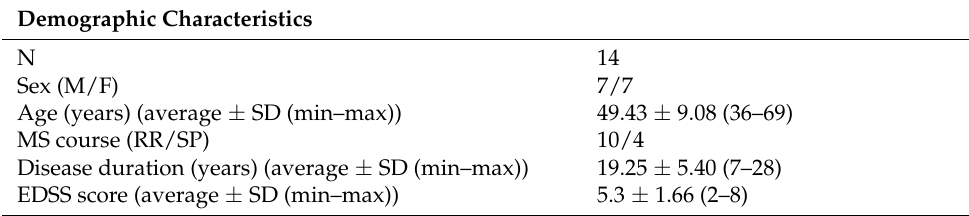
Table 1. Demographic characteristics of the enrolled